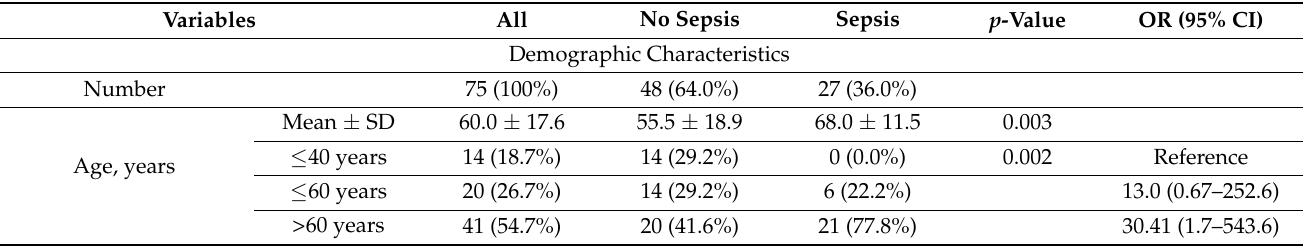
Table 2. Demographic and clinical features of ICU admitted patients with and without sepsis.